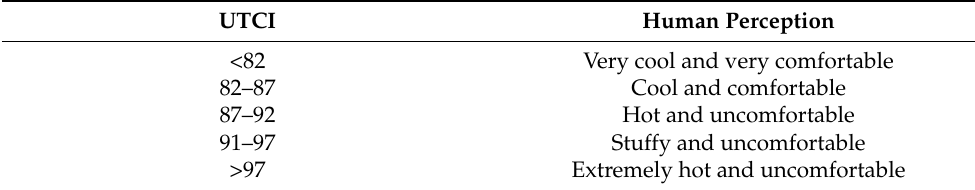
Table 2. THI classification Standard